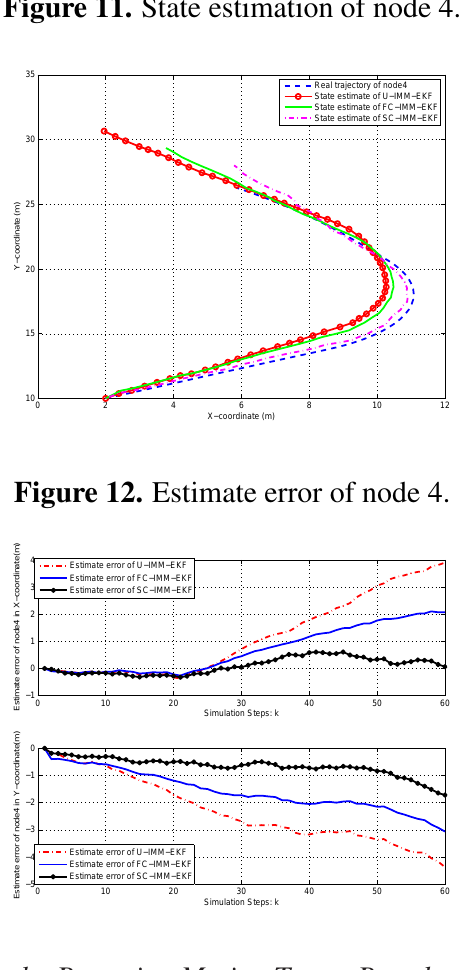
Figure 11. State estimation of node 4.